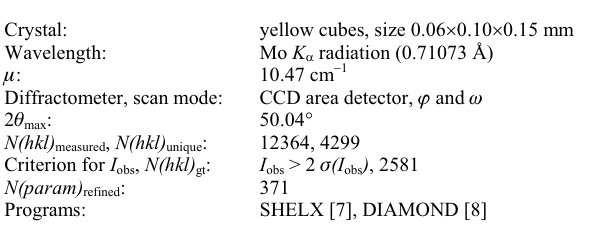
Table 1. Data collection and handling.